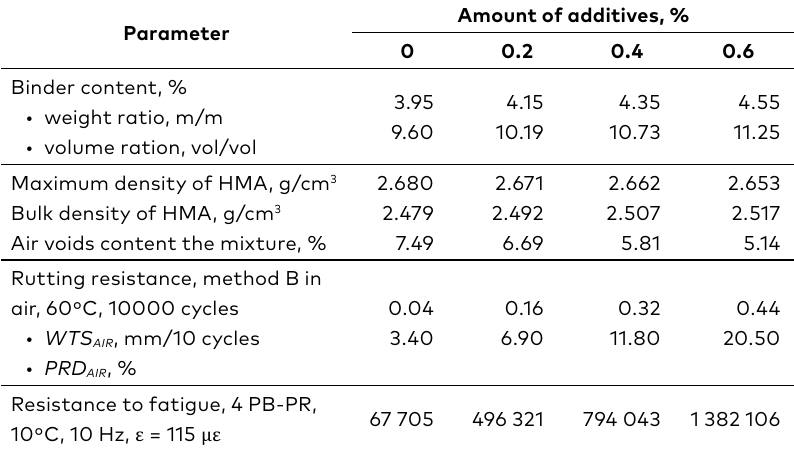
Table 4. Experimentally determined parameters of the tested bituminous mixture*